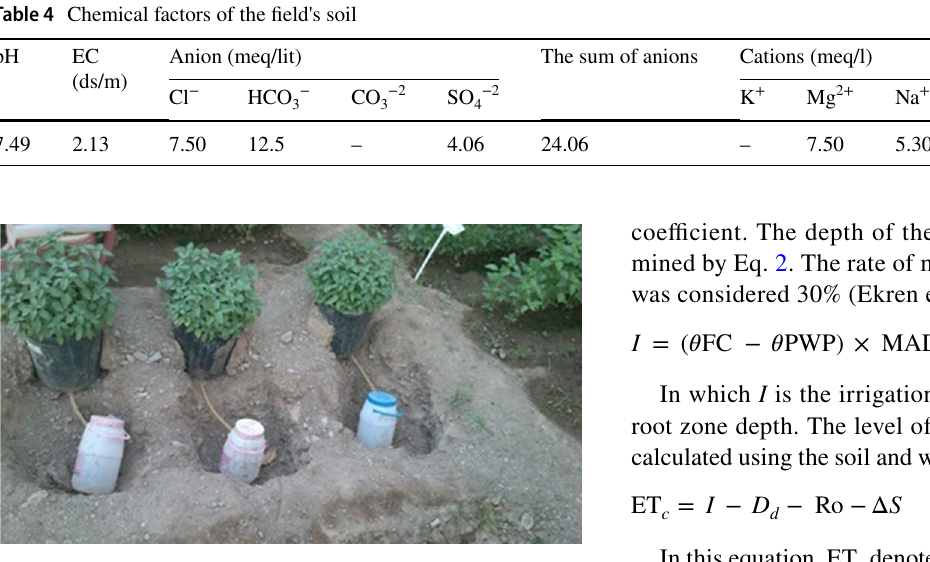
Fig. 1 Suggested micro-lysimeter in Doshan Tappeh research site